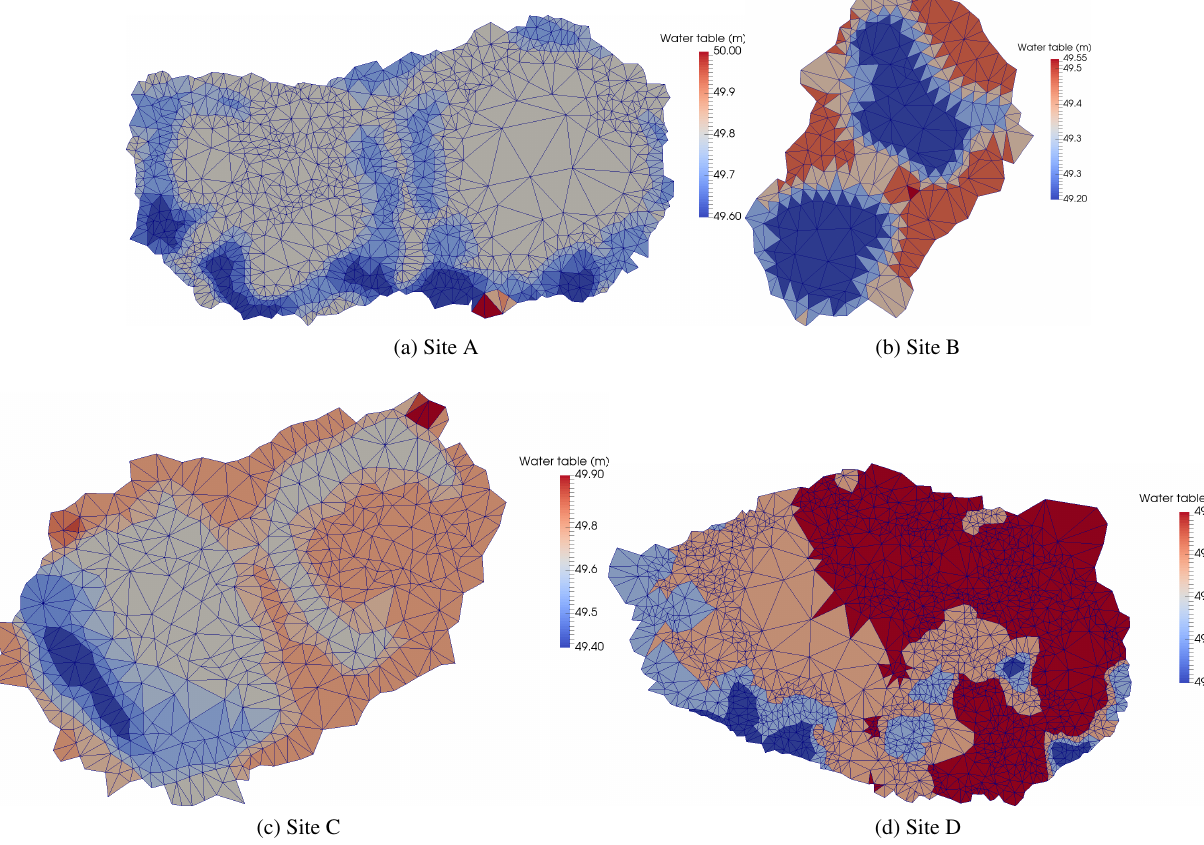
Figure E4. Elevation of maximum water table across the study region. Ground surface is at 50m elevation. The bold line represents the mean thaw depth across the site, while the shaded curve represents standard